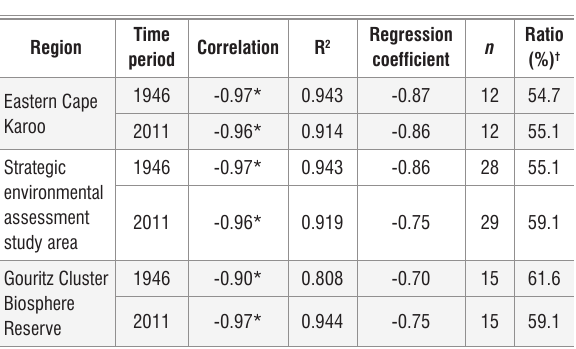
values against 10